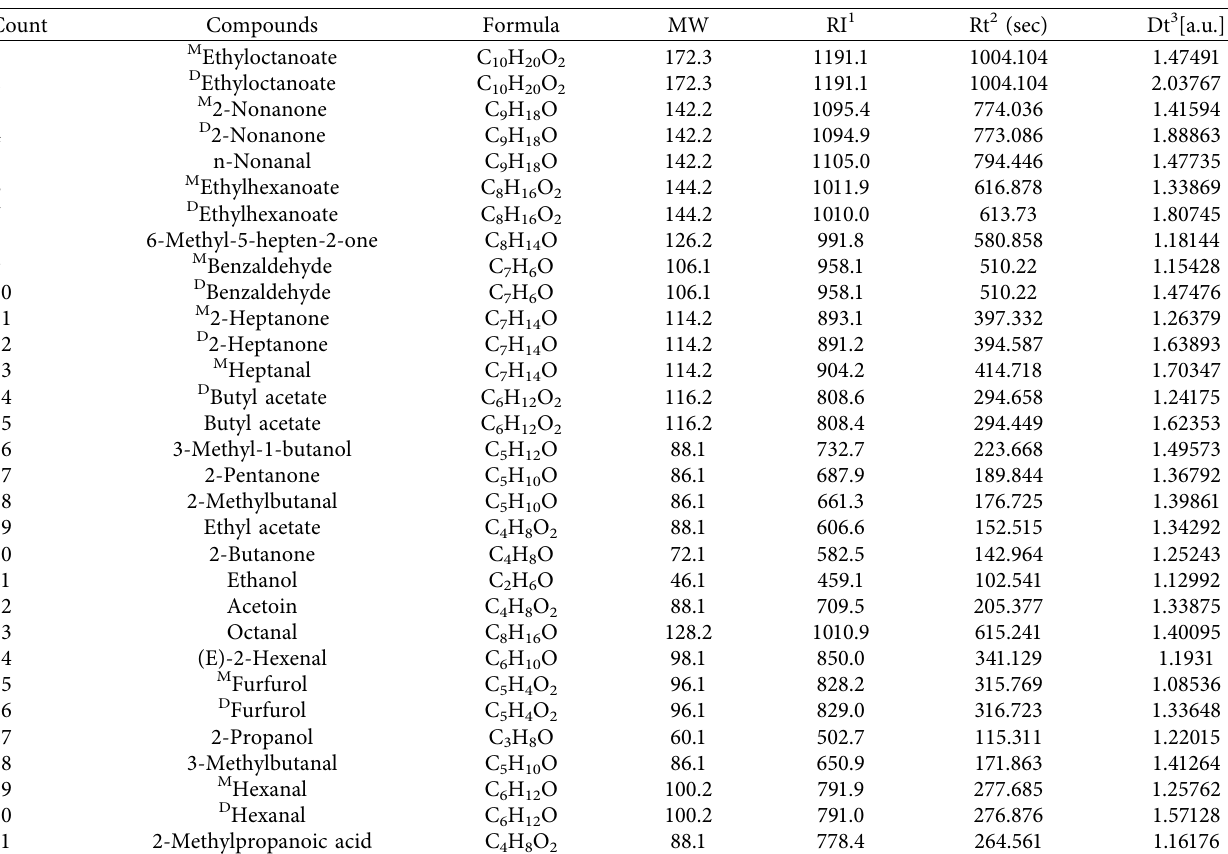
Figure 2: (a) Topographic plots for the selected markers obtained from the RJ stored at − 20 ° C; (b) topographic plots for the selected markers obtained from the RJ stored at 28 ° C. Table 1: Identified compounds in the RJ